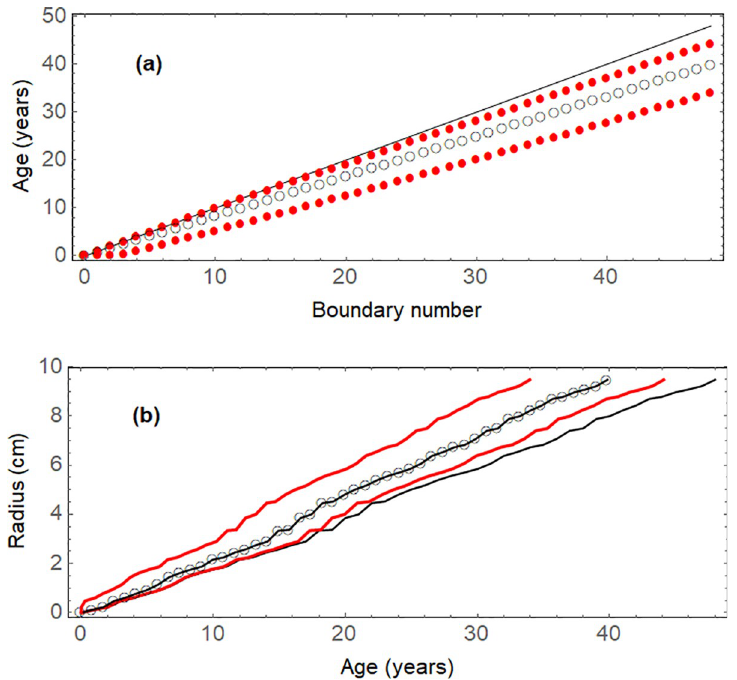
Fig 5. Uncertainty about ages of tree-ring boundaries. (a) estimated ages in years with 95% confidence limits (red) points; the points cannot be above the (black) diagonal line, where the age is equal to the boundary number; (b) radius as a function of estimated age, with 95% confidence limits (points are linearly interpolated). While the (black) thinner, lower line represents the upper age limit, the lower age limit is given by the Y -axis.